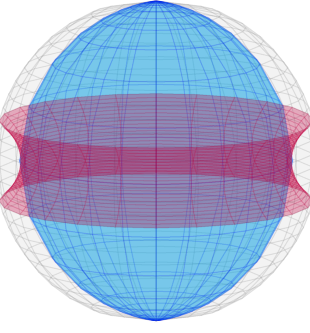
Figure 5 . The tube-like surface (purple) from (cid:12)gure 2b together with the surface of constant (cid:16) (blue) that marks its \turning point", (cid:16) (cid:3) . This particular surface has turning point (cid:16) (cid:3) (cid:24) 0 :